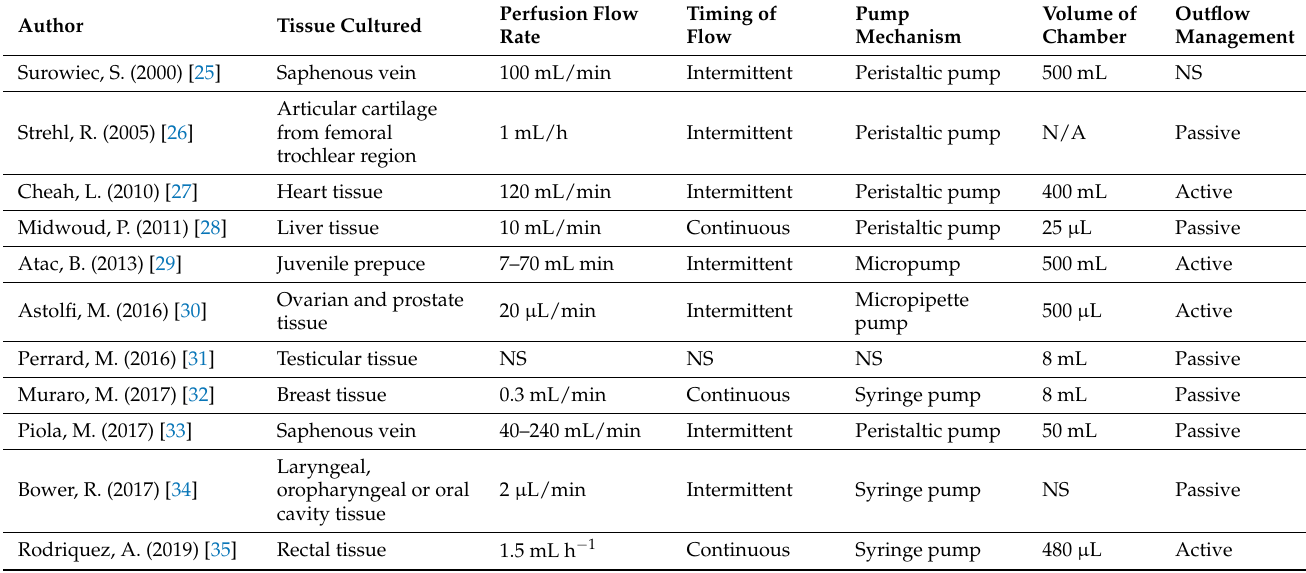
Figure 4. Dynamic perfusion culture. An illustration of dynamic perfusion culture technique. Active inflow of media into the bioreactor is driven by a mechanical pump. The inflow can be continuous or intermittent. An outflow exit channel is required in order to prevent volume overload of the system. Outflow management may be passive in nature or may require active draining through a pumping mechanism. The red cylinders represent the cultured tissue. Adjacent culturing wells can be implemented in order to facilitate multi tissue culture. Further modifications to the system include a scaffold for tissue support and a channel for drug delivery. Table 3. Characteristics of studies utilising dynamic perfusion culture.